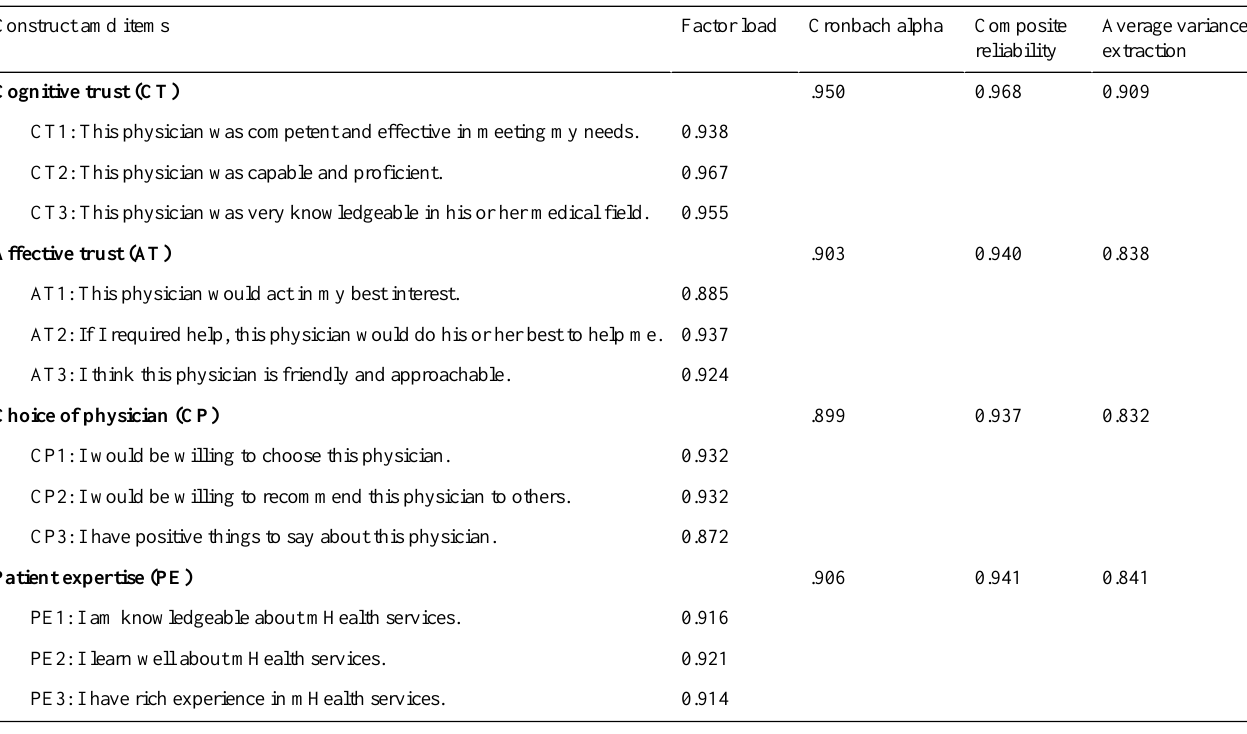
Table 4. Construct reliability and convergence validity.